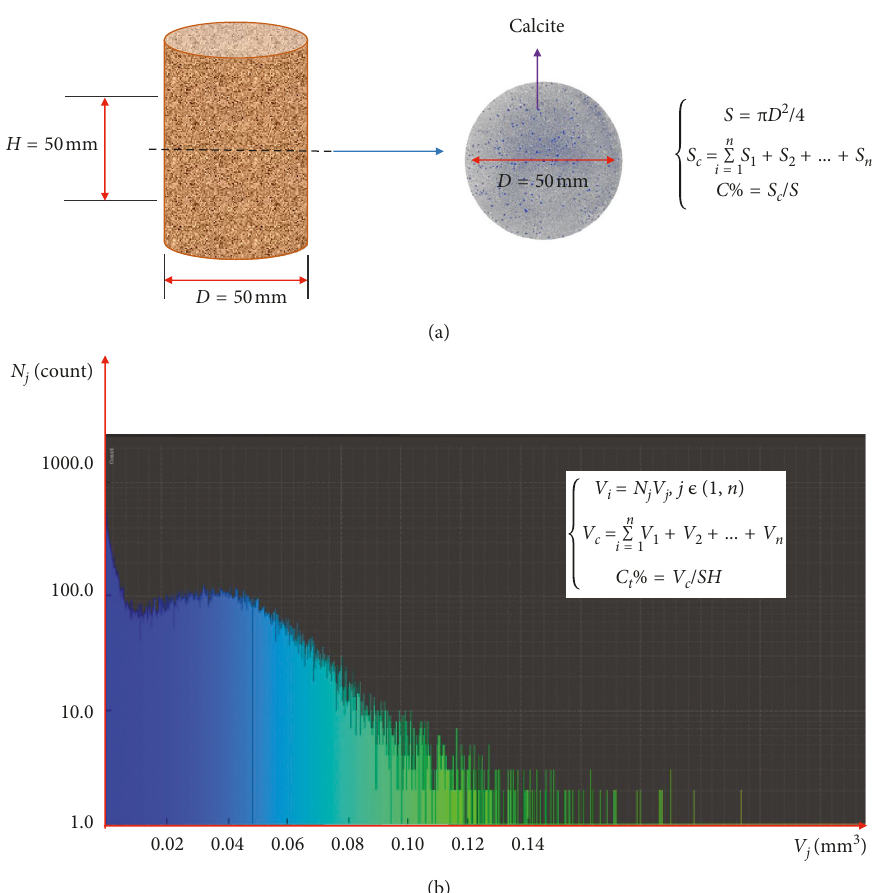
Figure 7: Extraction of characteristic information and crystal content statistics of calcium carbonate crystal. (a) Extraction of calcium carbonate crystal characteristic information. (b) Relationship between the number of calcium carbonate crystals and the corresponding volume (0.62 MPa).